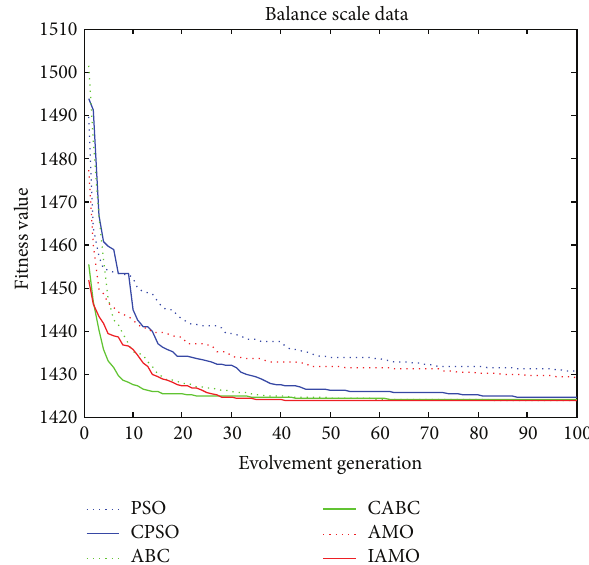
Figure 11: The convergence curve of the heart data.